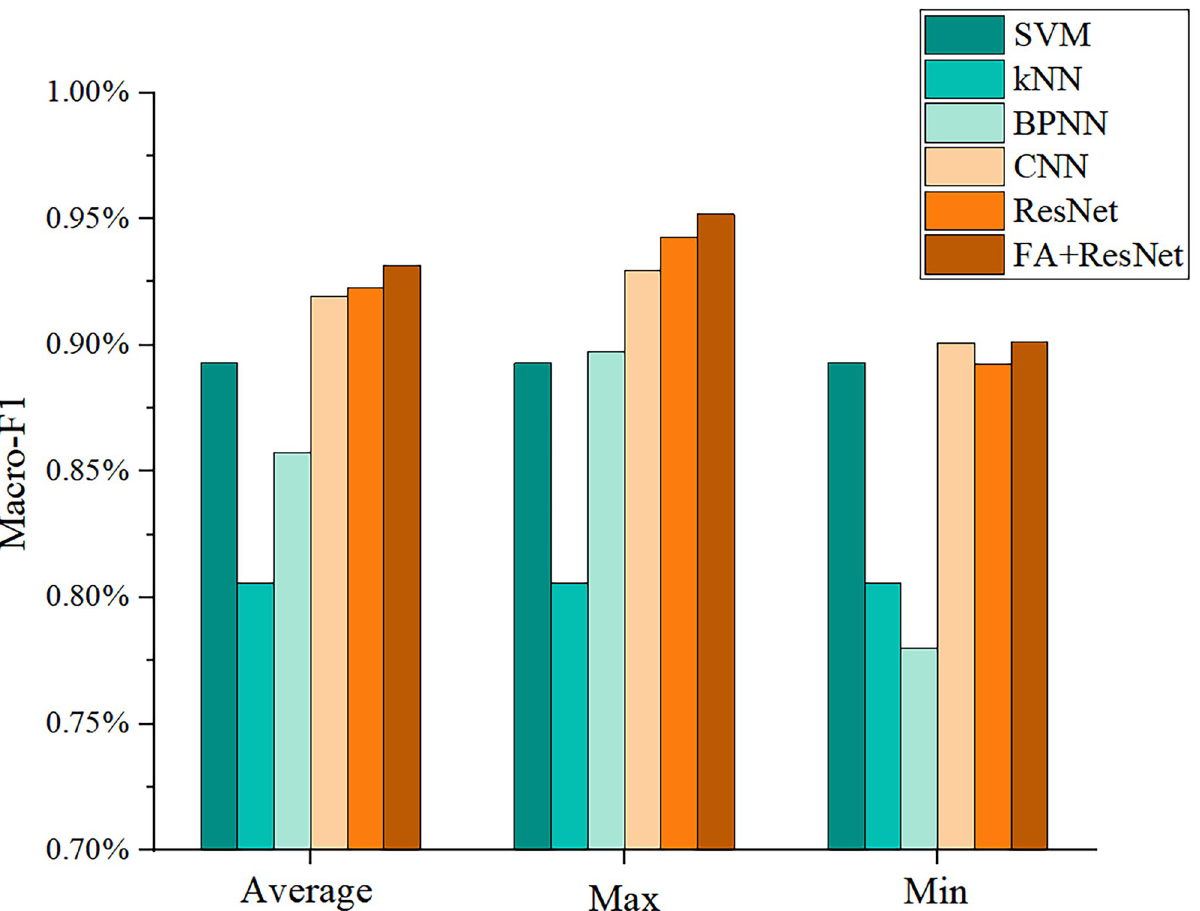
Fig 15. Visualization of Macro-F1 score of SVM, kNN, BPNN, CNN, ResNet, and FA+ResNet models in predicting suitable areas for premium teas.